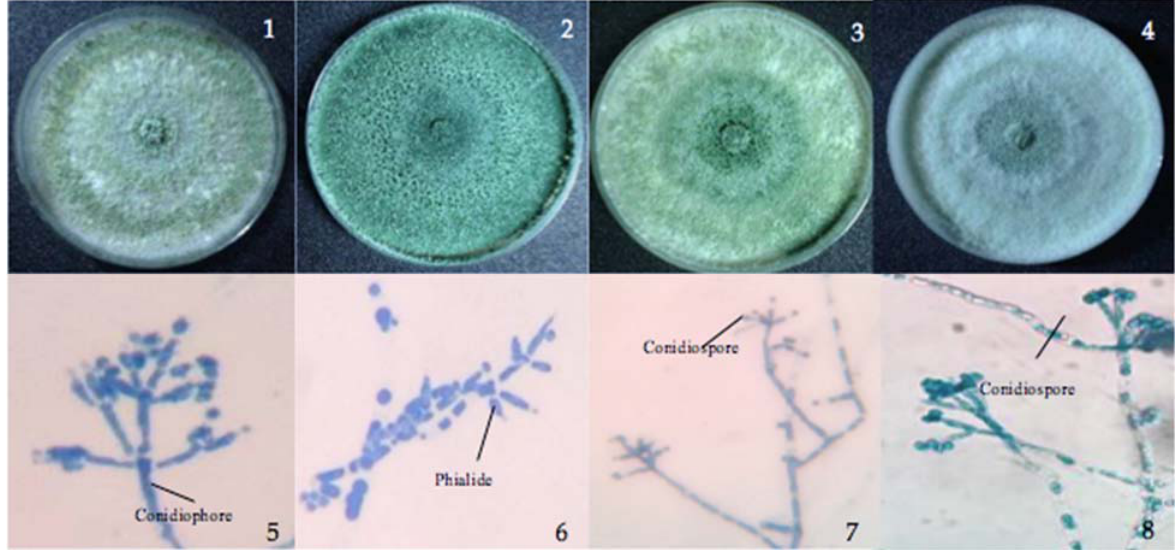
Figure 1. Cultures of Trichoderma . Colonies on TSM. ( 1 – 4 ) T. asperellum, T. inhamatum, T. virens, and T. harzianum . ( 5 – 8 ) Conidiophores, phialides, and conidia densely clustered on the wide main axis.